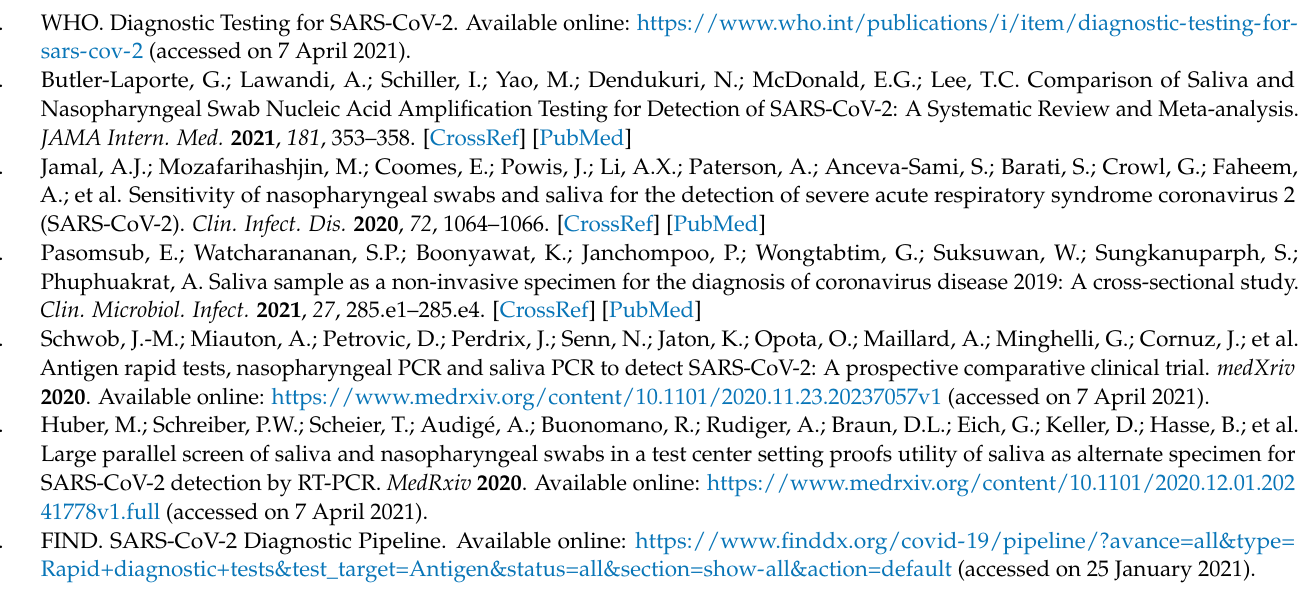
Figure S3: Agreement matrix of matched NP swab and saliva specimens, Figure S4: RAT sensitivity after stratification for viral load and duration of symptoms, Table S1: Limit of detection for “dry” versus “wet” swab procedure during the in vitro simulation